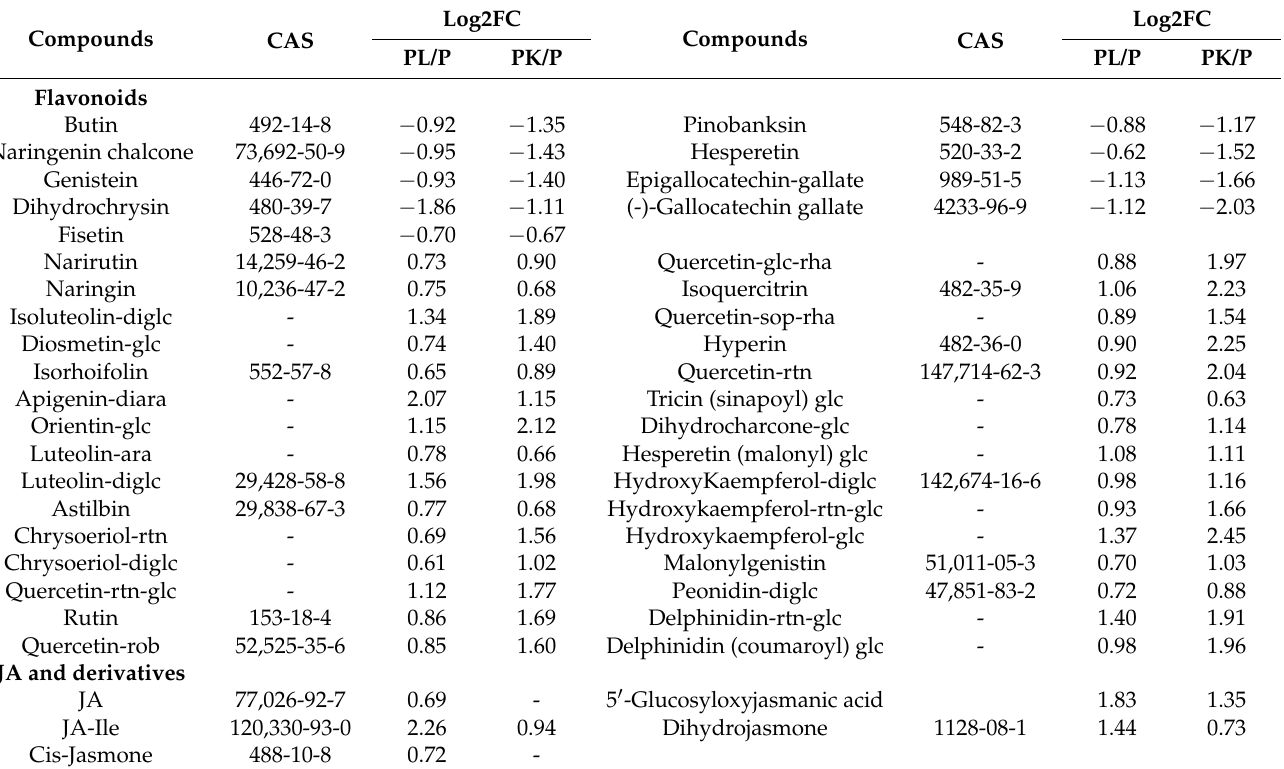
Table 1. The changed pattern of flavonoids and JAs in light- and K-treated D. officinale